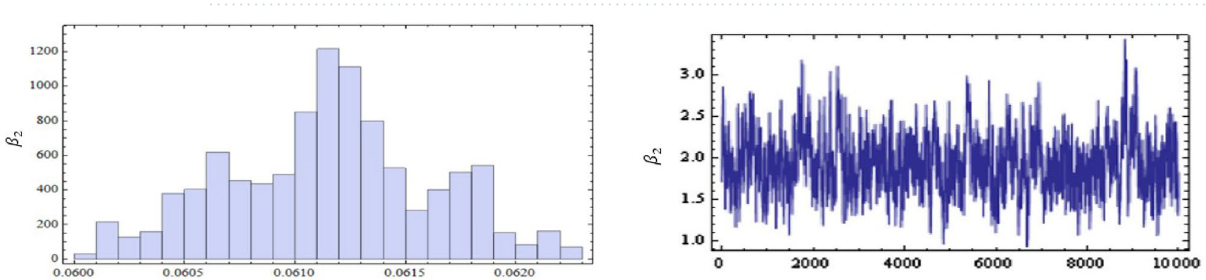
Figure 14. The posterior density function and the trace plots for the parameters β 2